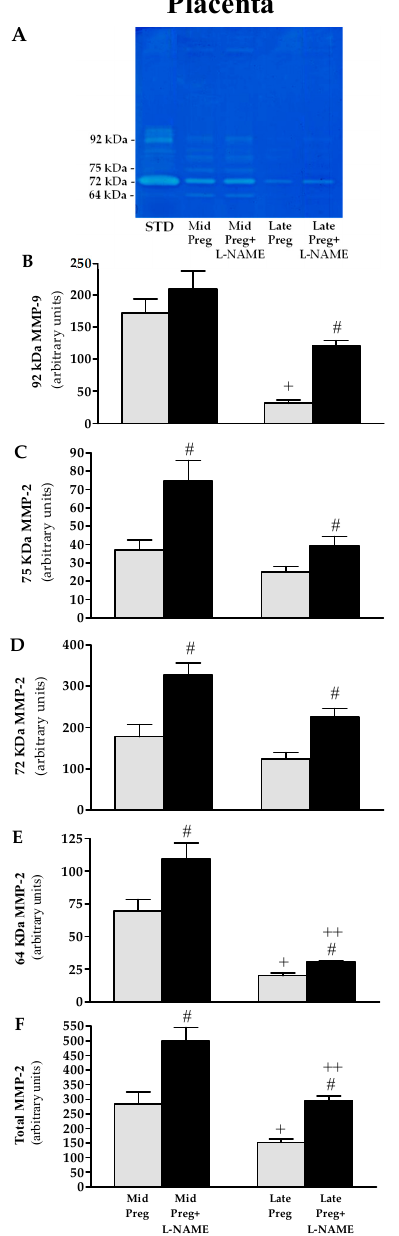
Figure 6. Representative zymography gel from the placenta ( A ). Gelatinolytic activity of 92 KDa mmP-9 ( B ), 75 KDa mmP-2 ( C ), 72 KDa mmP-2 ( D ), 64 KDa mmP-2 ( E ) and total mmP-2 ( F ) in middle (Mid) and Late-pregnant rats treated with saline or L-NAME. Values represent mean ± SEM. # P < 0.05 versus respective saline-treated group, and + P < 0.05 versus respective Mid-Preg group, ++ P < 0.05 versus respective Mid-Preg + L-NAME group for 64 KDa and total mmP-2